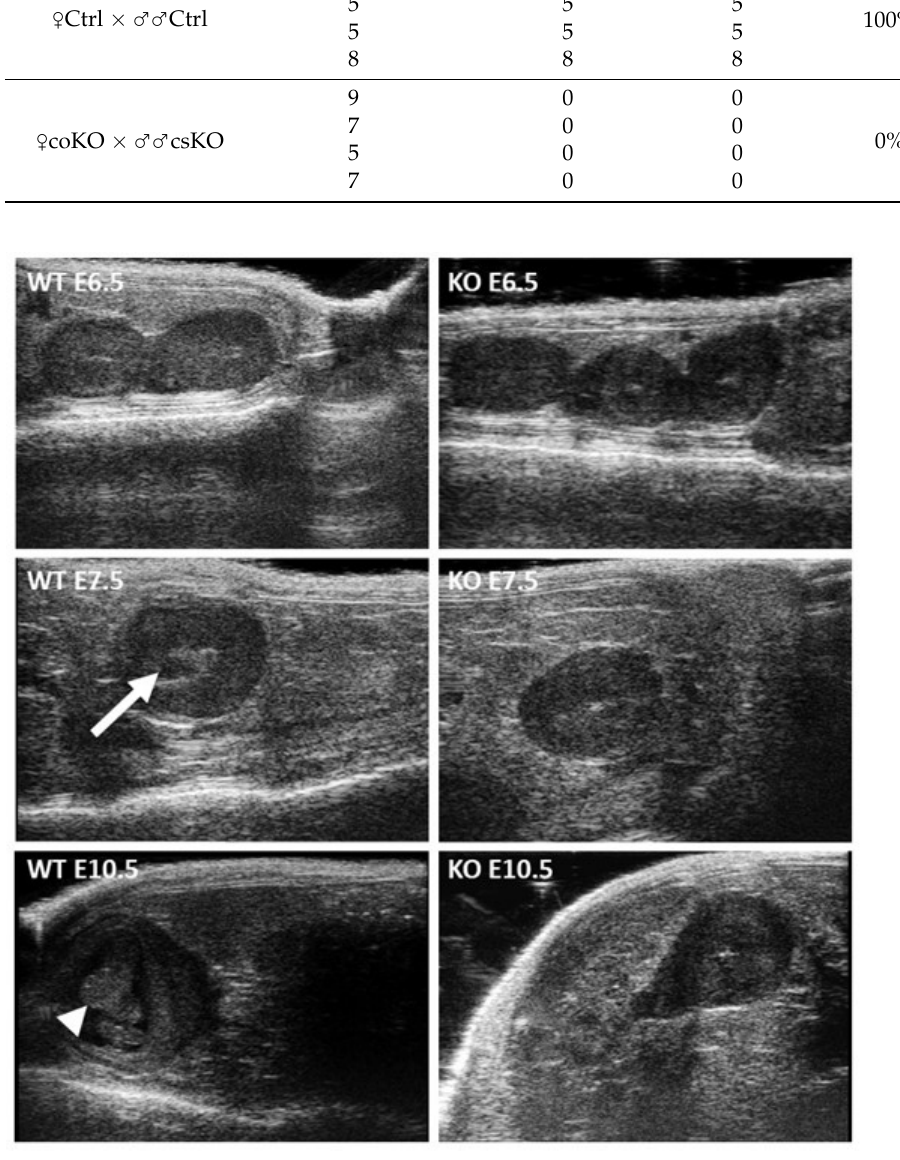
Figure 4. In vivo ultrasound microscopic observation of the embryonic development. During the gestation of control (WT, Zp3-Cre − / − Itgb1 flox/flox females mated with Stra8-Cre − / − Itgb1 flox/flox males) and KO ( Zp3-Cre +/ − Itgb1 flox/flox females mated with Stra8-Cre +/ − Itgb1 flox/flox males) animals, the em- bryonic development was followed up by an in vivo ultrasonic method at E6.5, E7.5 and E10.5. No difference was observed at E6.5. At E7.5, less amniotic fluid was visible in the KO group compared to the control group (arrow). At E10.5, the embryo was no longer visible in the KO group compared to the control group (arrowhead). The viability of developing embryo was confirmed by the pres- ence of heartbeats.